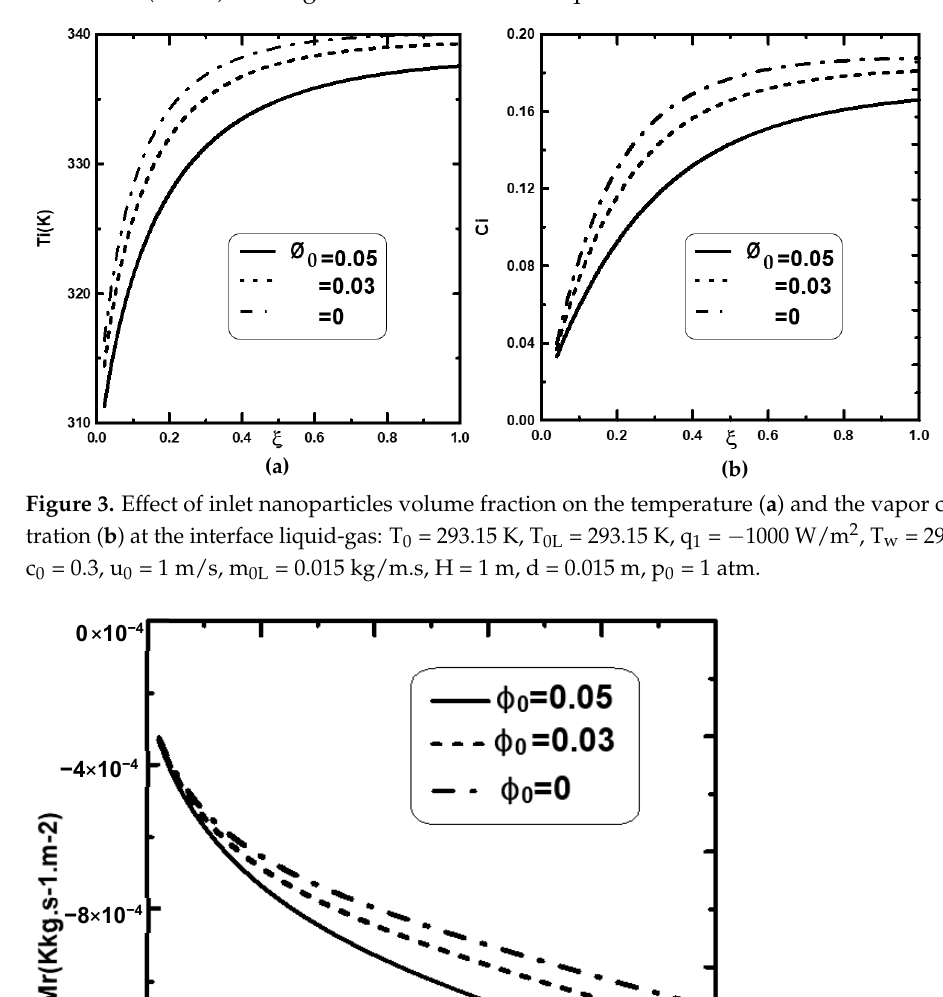
Figure 5. Effect of inlet nanoparticles volume fraction on the latent (a) and sensible (b) heat fluxes: T 0 =293.15 K, T 0L =293.15 K, T w =293.15 K, q 1 = − 1000 W/m 2 , c 0 =0.3, u 0 =1 m/s, m 0L =0.015 kg/m.s, H=1 m, d=0.015 m, p 0 =1 atm.